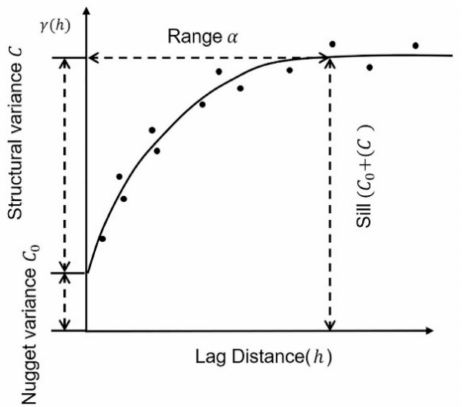
Figure 3. A schematic diagram of the semi-variance analysis with its key parameters